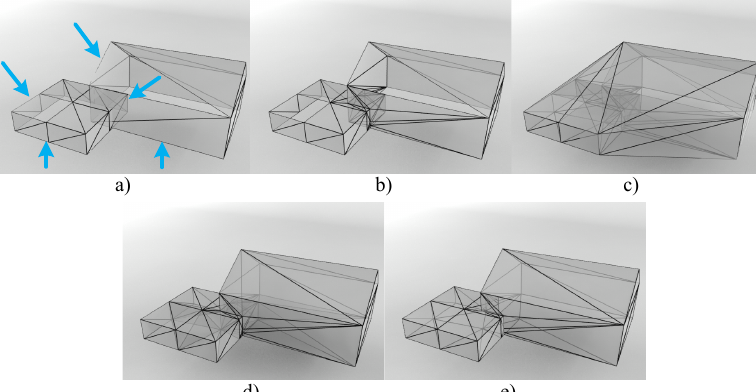
Figure 11. The experimental result of a flawed building model (a) the tessellated input model with intersecting building parts and several missing surfaces; b) the decomposition result of the model; c) the convex hull of the input model and itself are sent to the tetrahedralization; d) the carving result; e) the extracted exterior surface, which is a watertight valid model )